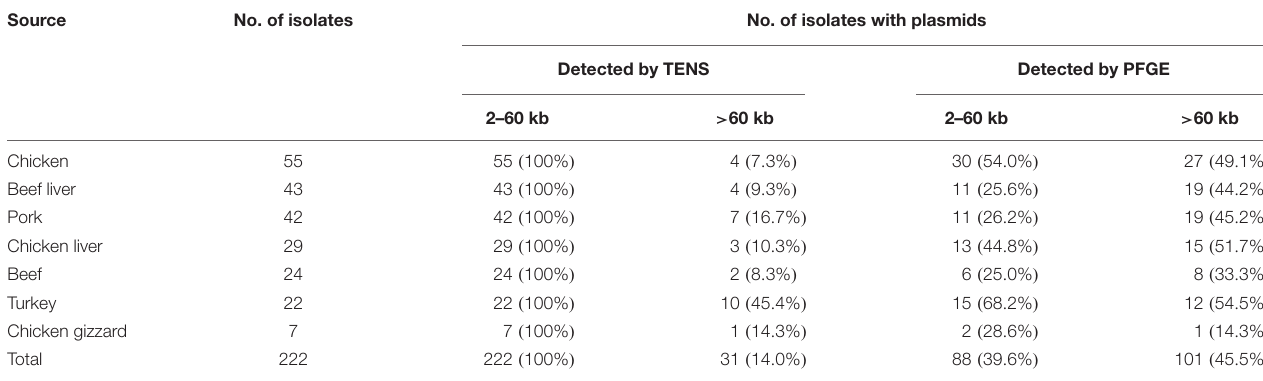
FIGURE 3 | The distribution of detected plasmids in S. aureus isolates according to plasmid sizes applying TENS and PFGE methods. In case the same plasmid size were detected by both methods, only one plasmid was counted. TABLE 1 | The prevalence of plasmids in S. aureus isolated from various retail meats by alkaline lysis (TENS) and